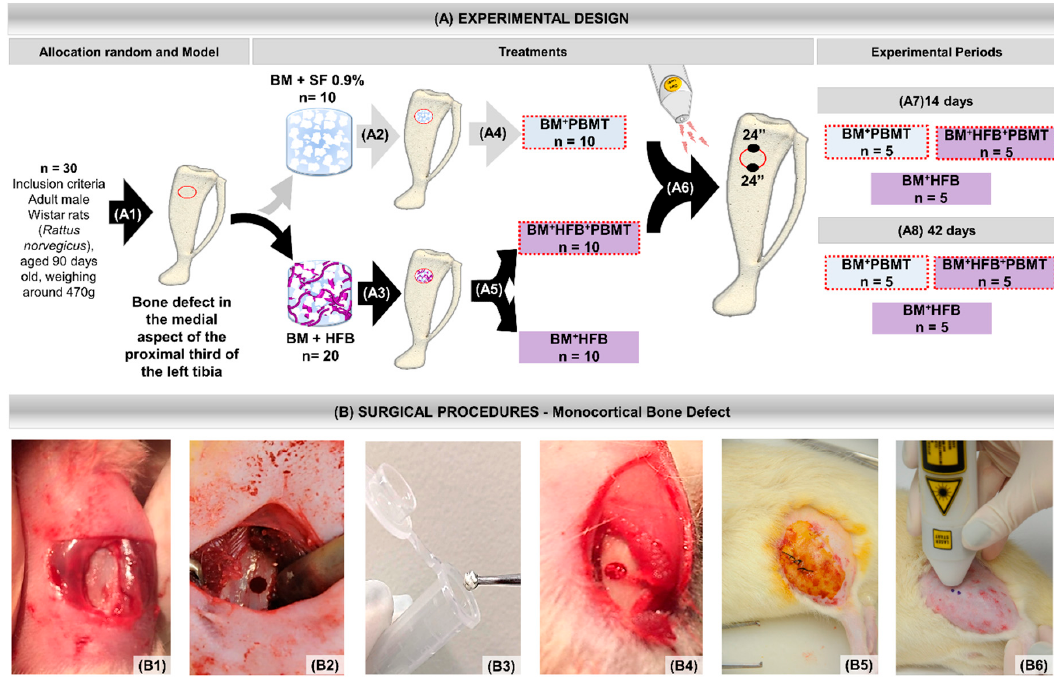
Figure 1. ( A ) Experimental design. ( A1 ) Monocortical osteotomy in the medial aspect of the proximal third of the tibia. ( A2 ) Defects filled with biomaterial (BM) mixed with saline (SF). ( A3 ) Defects